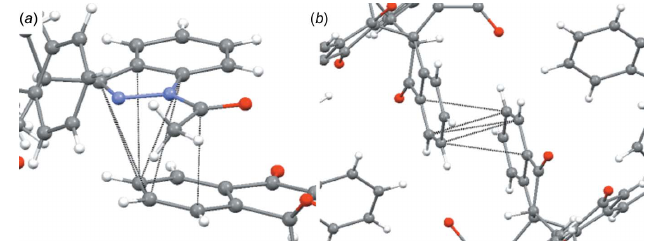
Figure 5 (cid:2) – (cid:2) stacking between ( a ) arms 4 and 5 of adjacent molecules and ( b ) arms 1 and 2 of the title compound.